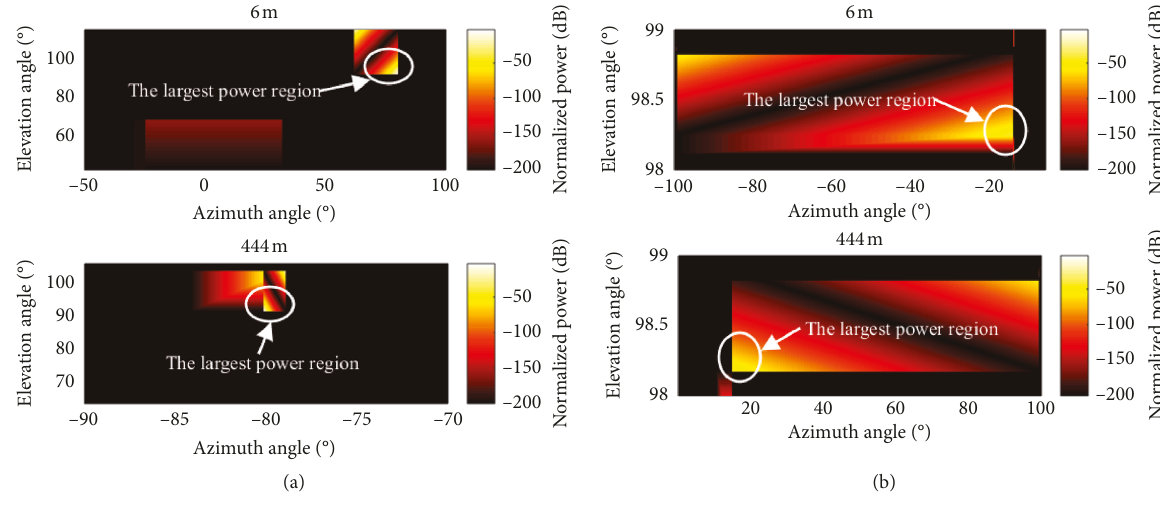
Figure 8: (a) PAS of AoA. (b) PAS of AoD.